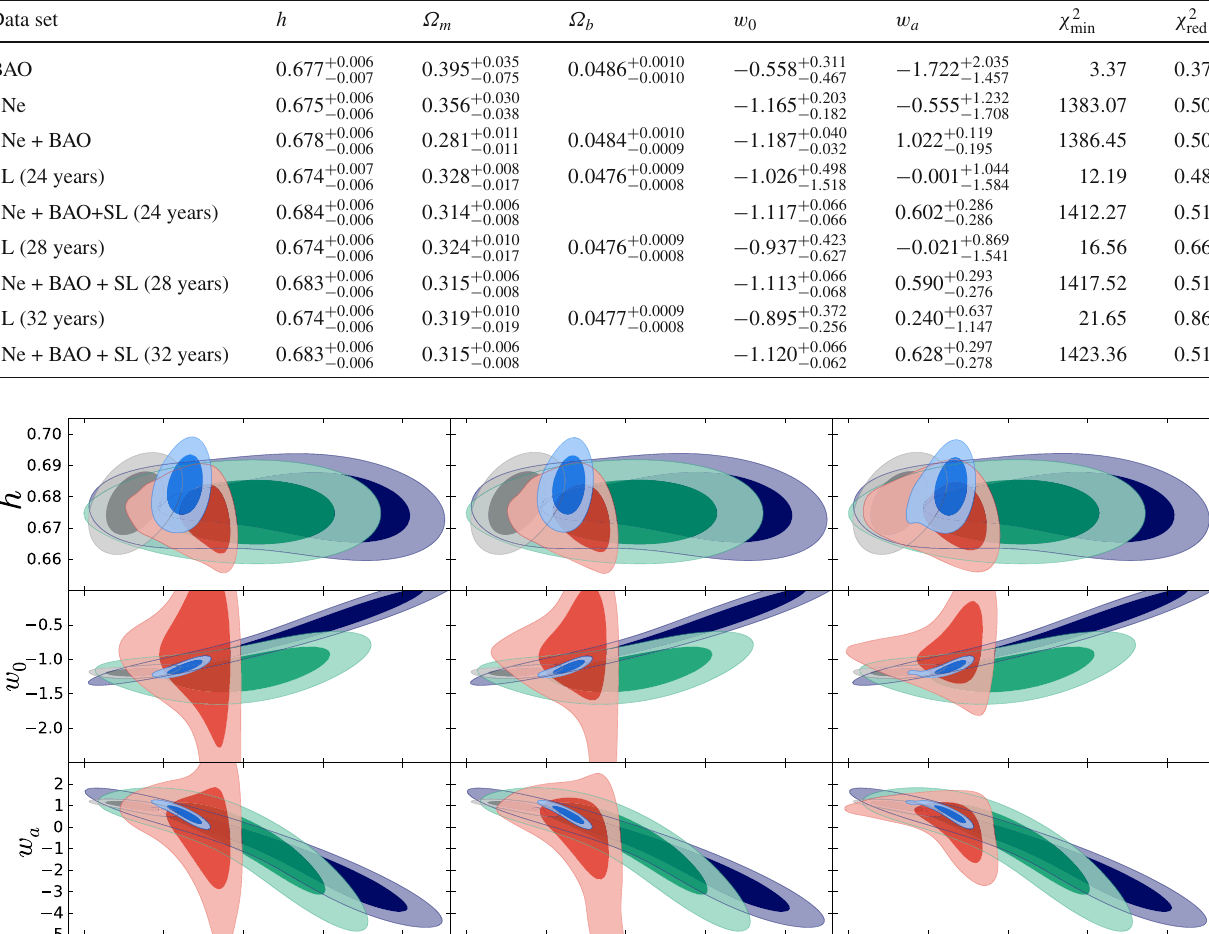
Table 5 Parameter results of the CPL model